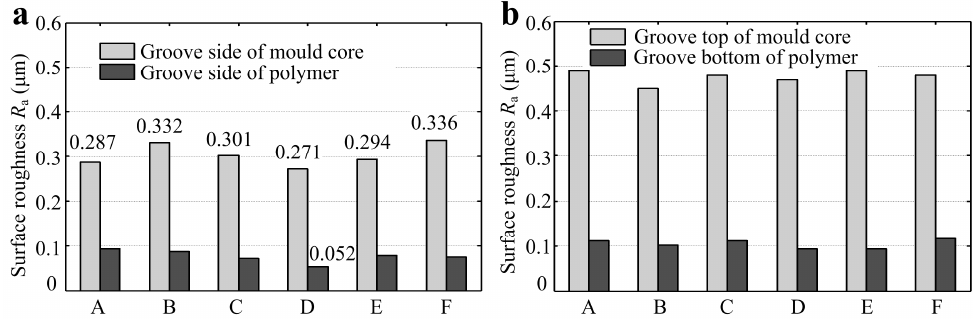
Figure 11. Comparisons of surface roughness R a of micro-structured mold cores and polymers: (a) groove sides of mold core and polymer; (b) groove top of mold core and groove bottom of the polymer.